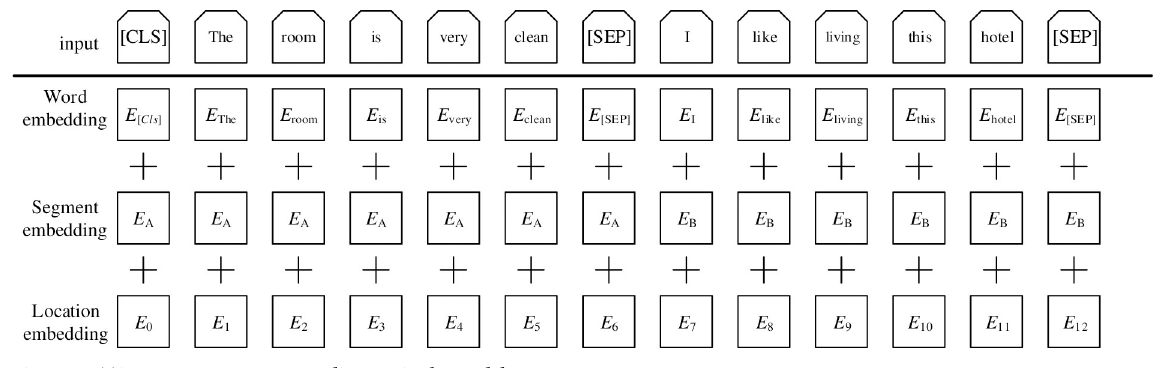
Fig 2. BERT input sequence structure diagram in the model.